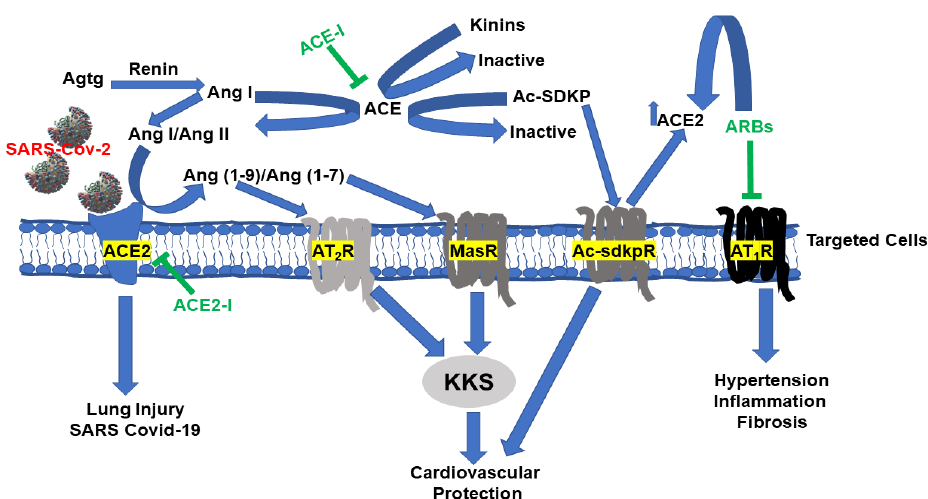
Figure 3. Relationship between RAS and SARS-CoV2: Angiotensinogen (Agtg) is converted to Angiotensin I (Ang I) by renin, which in turn is converted to Ang II by ACE or Ang (1–9) by ACE2 during ACE-I treatment. Ang II is also converted by ACE2 to Ang (1–7) during ARB. ACE-Is and ARBs increase ACE2 expression and activity in animal and human studies through mechanisms that remain to be elucidated. In addition, ACE-I increases circulating and tissue Ac-SDKP, which in turn increases ACE2. Ang II acting through AT 1 receptor mediate most of the detrimental cardiovascular e ff ects of Ang II through AT 1 receptors (AT 1 R). Those e ff ects are blocked by ACE-I or angiotensin receptor blockers (ARBs). Activation of AT 2 by Ang (1–9) or mitochondrial assembly receptor (MasR) by Ang (1–7) mediate some of the protective e ff ects of ACE-I and ARBs). A large population of hypertensive patients is treated with either ACE-I or ARBs, making them at high risk for SARS-CoV-2 associated morbidity and mortality. Binding of ACE2 to SARS-CoV2 leads to viral entry and replication, leading to severe lung injury. ACE2 also degrades desArg 9 -BK but not BK. Potential therapeutic approaches include a SARS-CoV-2 spike protein-based vaccine, blocking the surface ACE2 receptor by using an ACE2 inhibitor, or use of B 1 receptor antagonists during the period of the propagation of the virus to halt viral spread and the lung or other organs from injury.